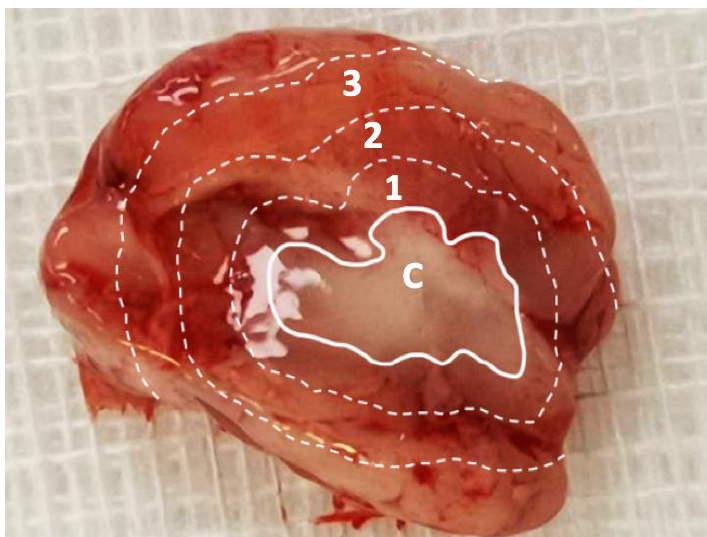
Figure 1. Division of sampling zone. The injected SN-38-embedded poly[( d , l )-lactide- co -glycolide] microparticles (SMPs) resulted in a white core, and the brain parenchyma was divided into zones 1–3 (each zone of thickness, ~2–3 mm) for tissue sampling. C: core, 1: zone 1, 2: zone 2, and 3: zone